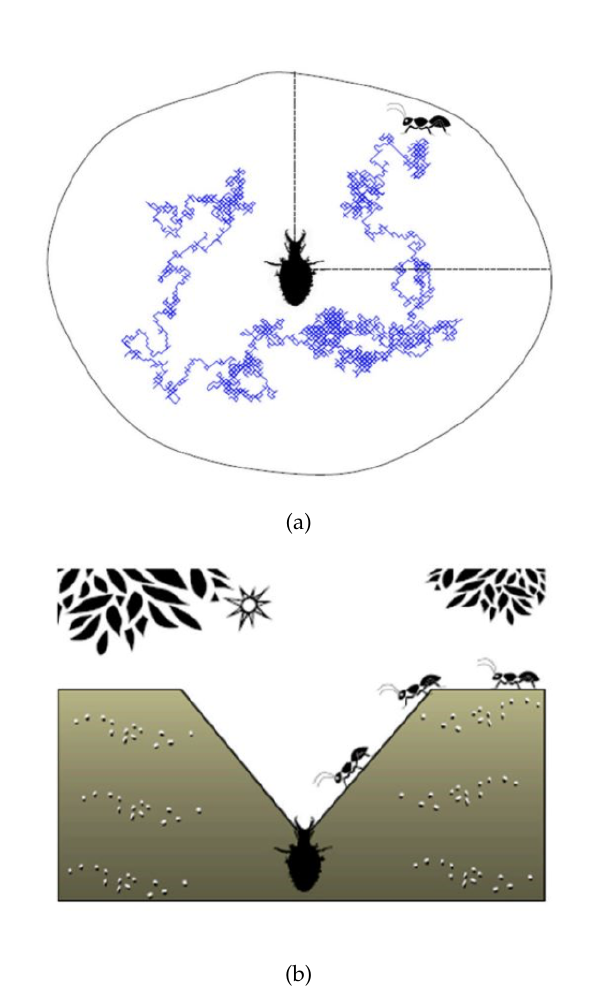
Parameter Symbol Unit Class Min. Max. Average S.